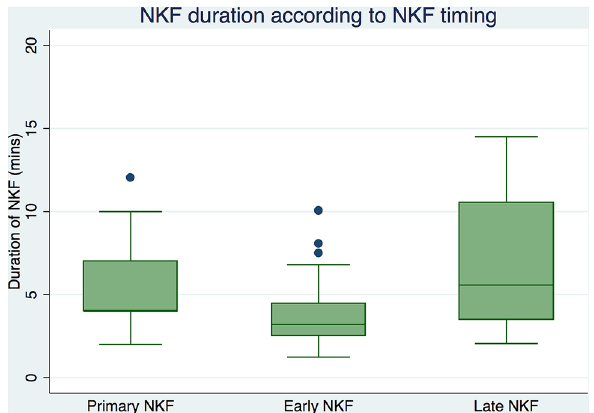
Figure 1. Statistically different times for performing needle-knife fistulotomy (NKF) with success among the 3 groups.